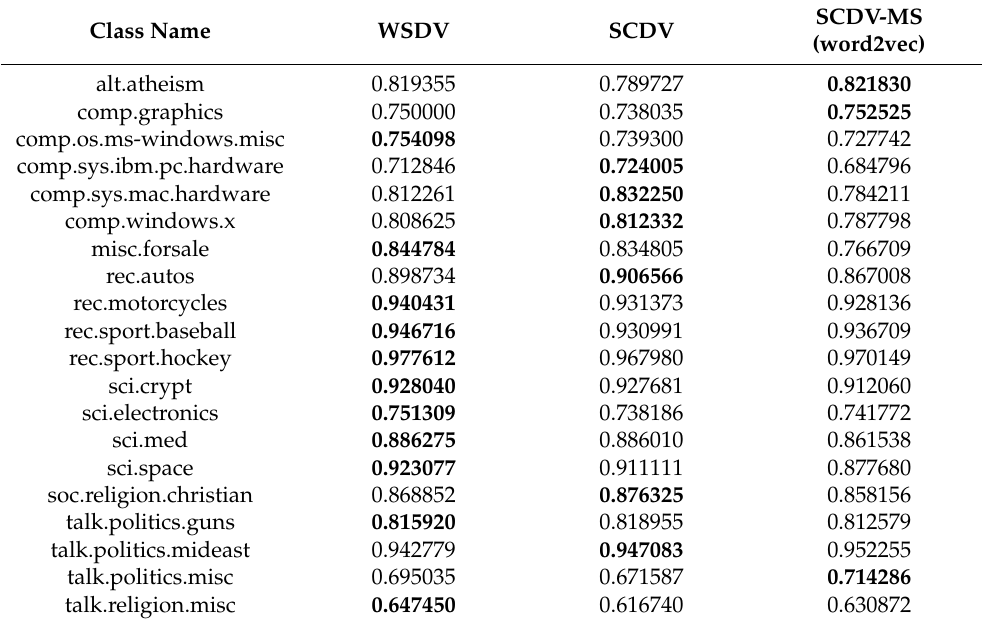
Table 3. Class-wise F1-Score comparison among the three most related models using the 20News- group dataset (20 clusters).